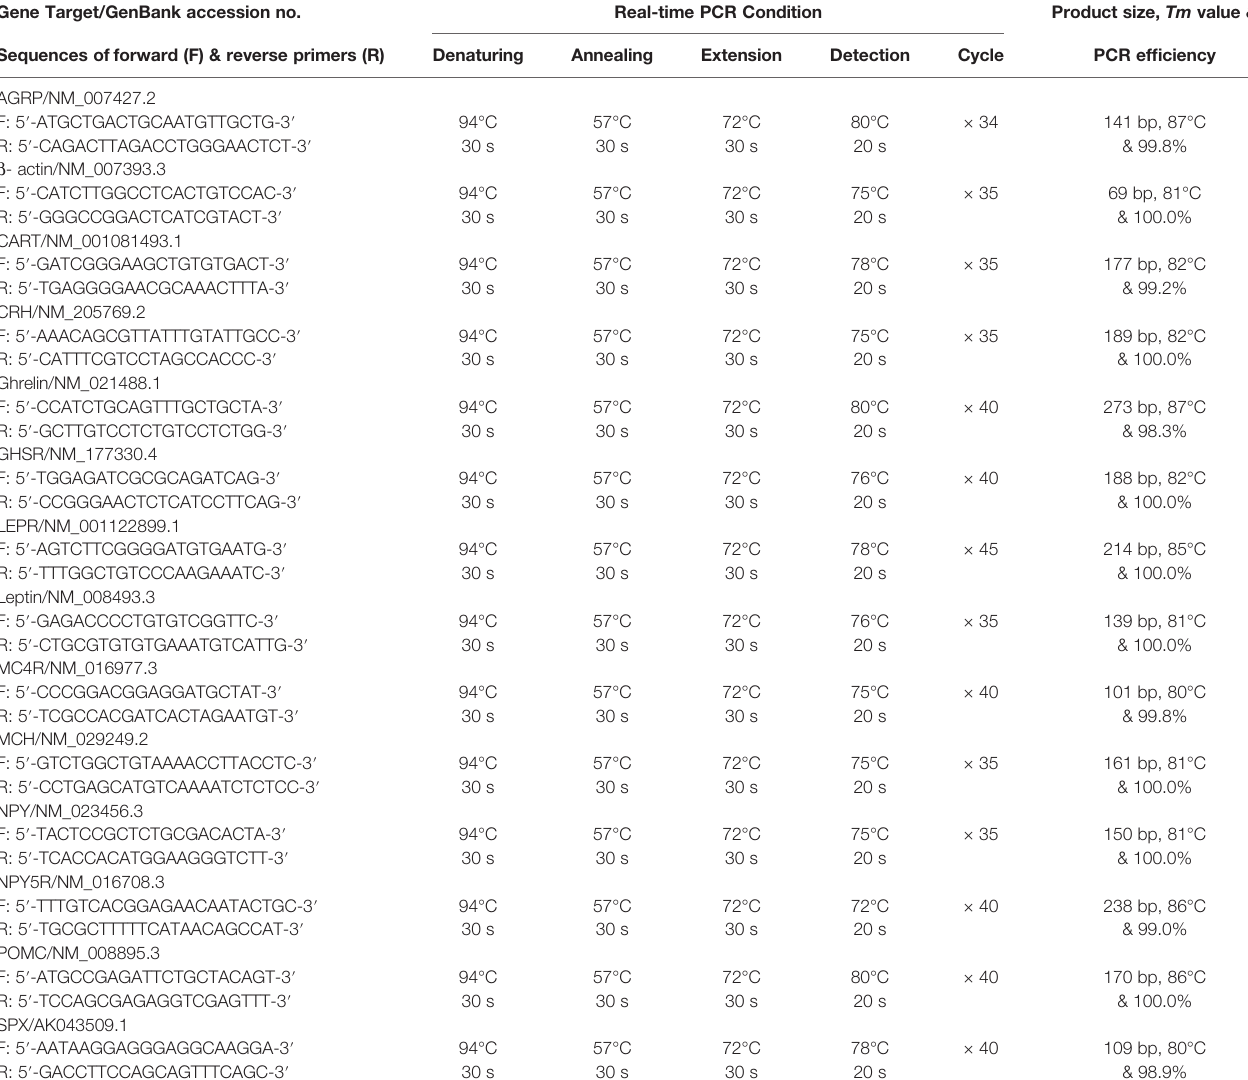
TABLE 1 | Primer sequences and PCR conditions for real-time PCR assays in mouse. Gene Target/GenBank accession